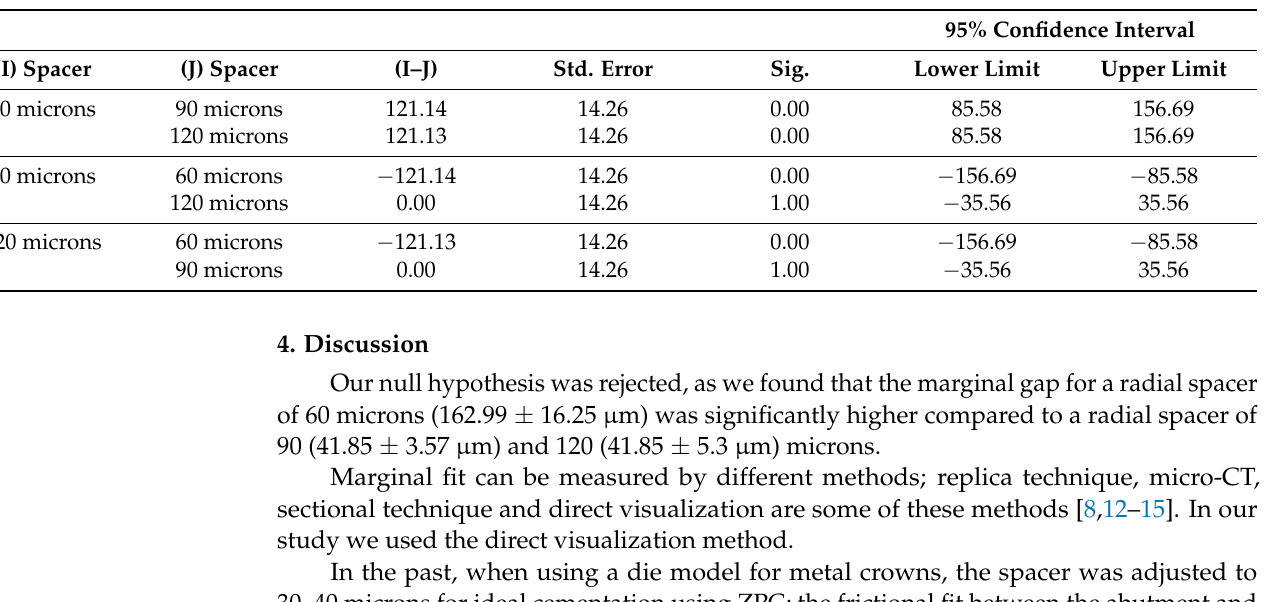
Figure 4. Box plot of all three groups. Table 2. Multiple comparisons with dependent variable of MMG ( α =